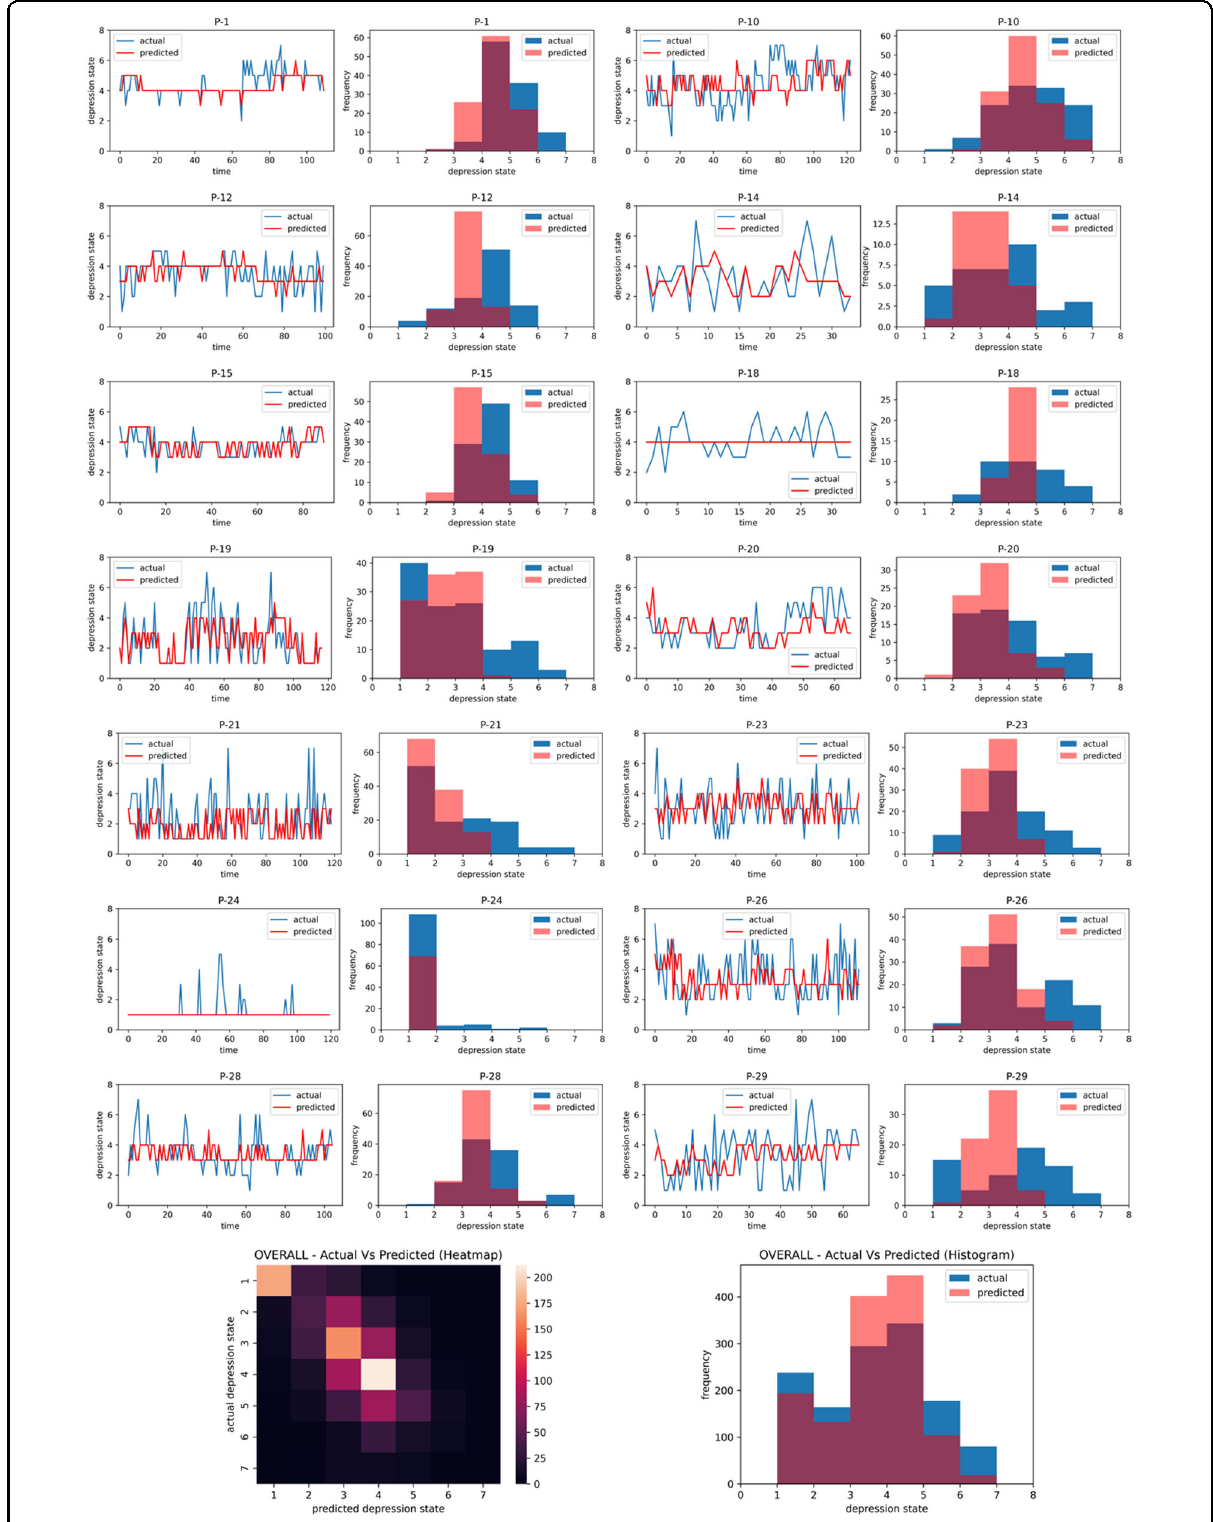
Fig. 2 Comparisons of actual depression states as self-reported by participants vs. their predicted depression states obtained from the personalized ML pipeline with fourfold CV. Actual and predicted value comparisons are shown over time with each EMA serving as one time- step, and also compared as per their histogram distributions. The bottom row plots show the heatmap and histogram comparisons for actual vs. predicted values across all